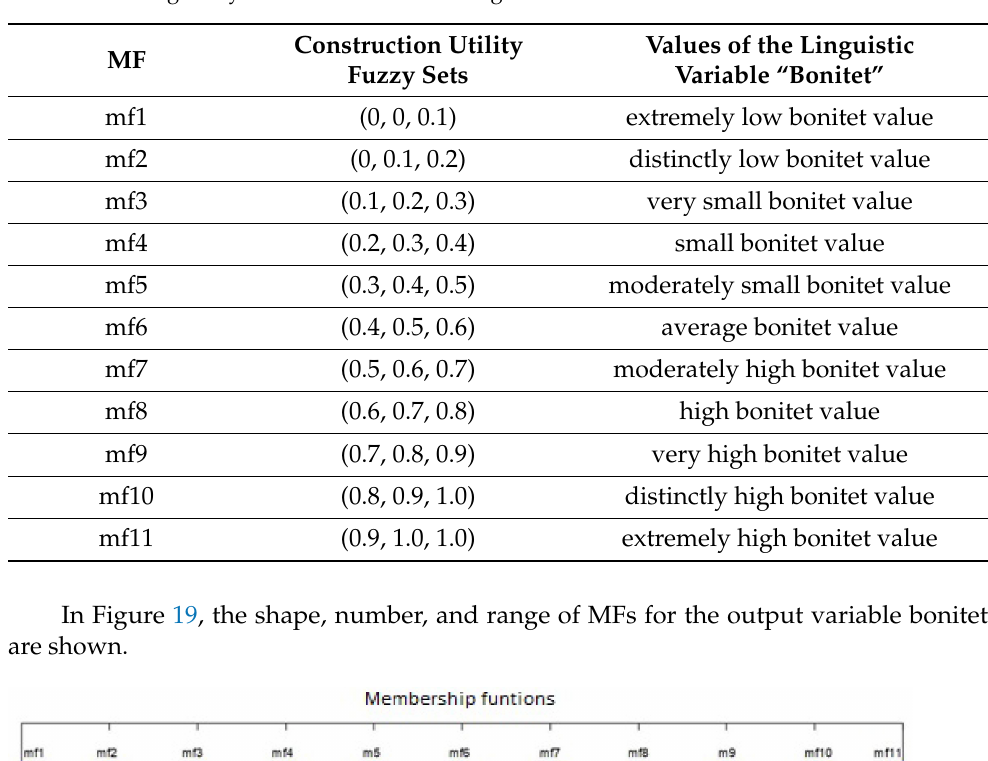
Table 9. Defining fuzzy sets and values of the linguistic variable “Bonitet”.